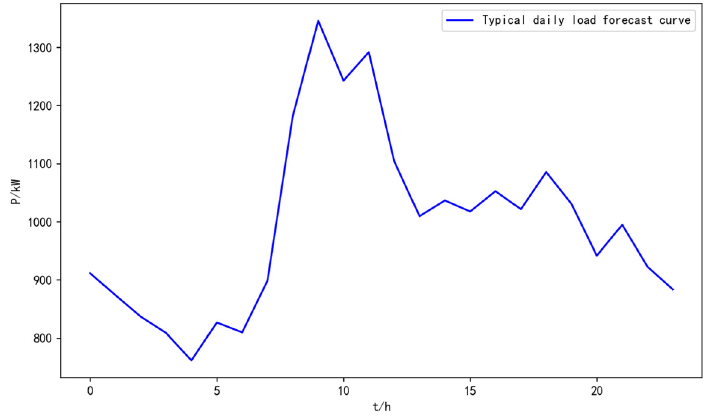
Figure 2. Typical daily load curve of non-summer industrial and commercial in Shanghai.